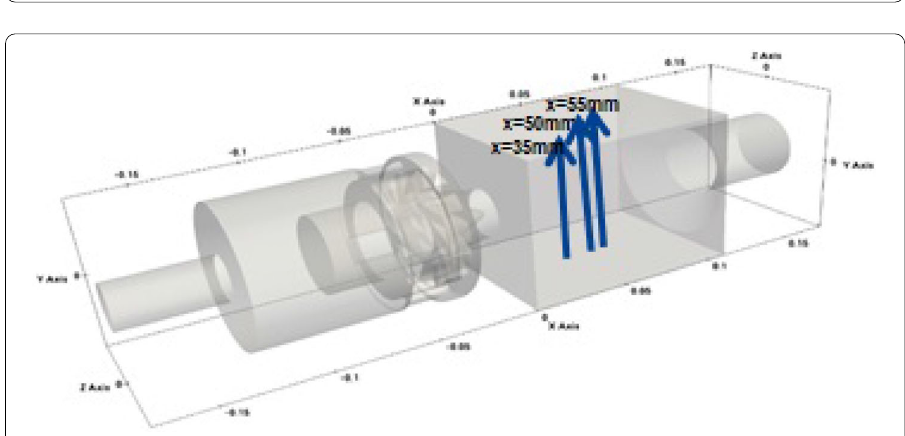
Fig. 52 Smaller RFD. On the left, the third component of the root mean square flow field by the UGPOD applied to configuration 1. On the right, the third component of the high fidelity root mean square flow field with configuration 1